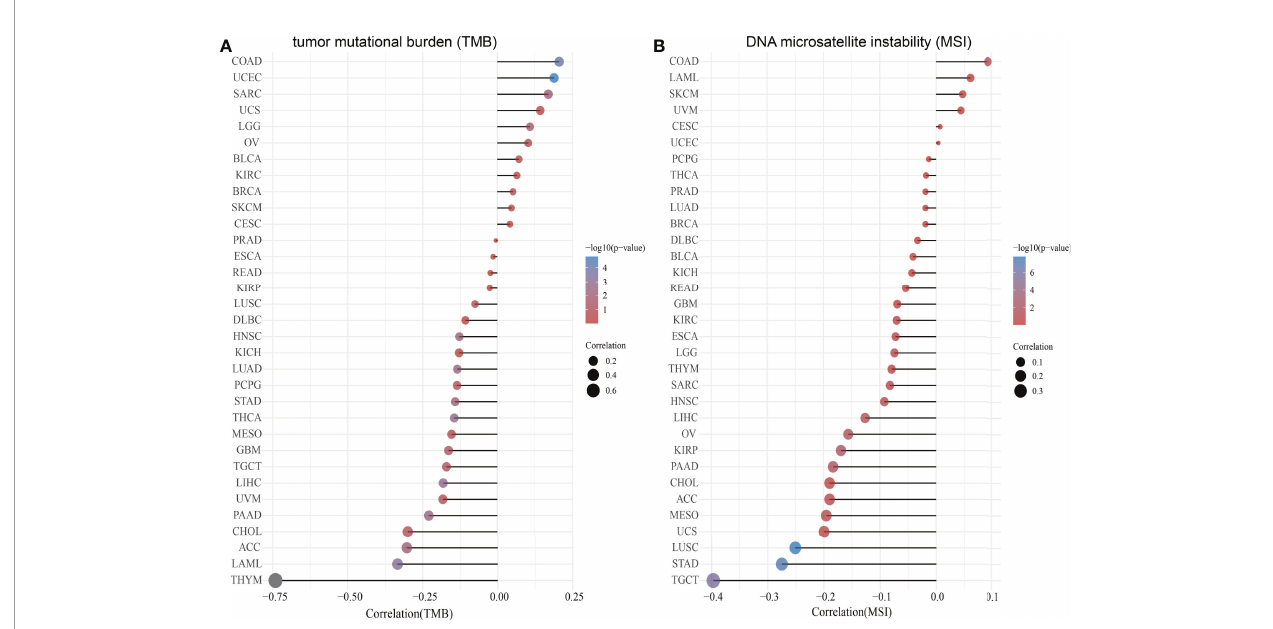
FIGURE 9 | Correlation between SASH3 expression and TMB and MSI. (A) Analysis of the correlation between SASH3 and TMS in pan-cancer. (B) Analysis of the correlation between SASH3 and MSI in